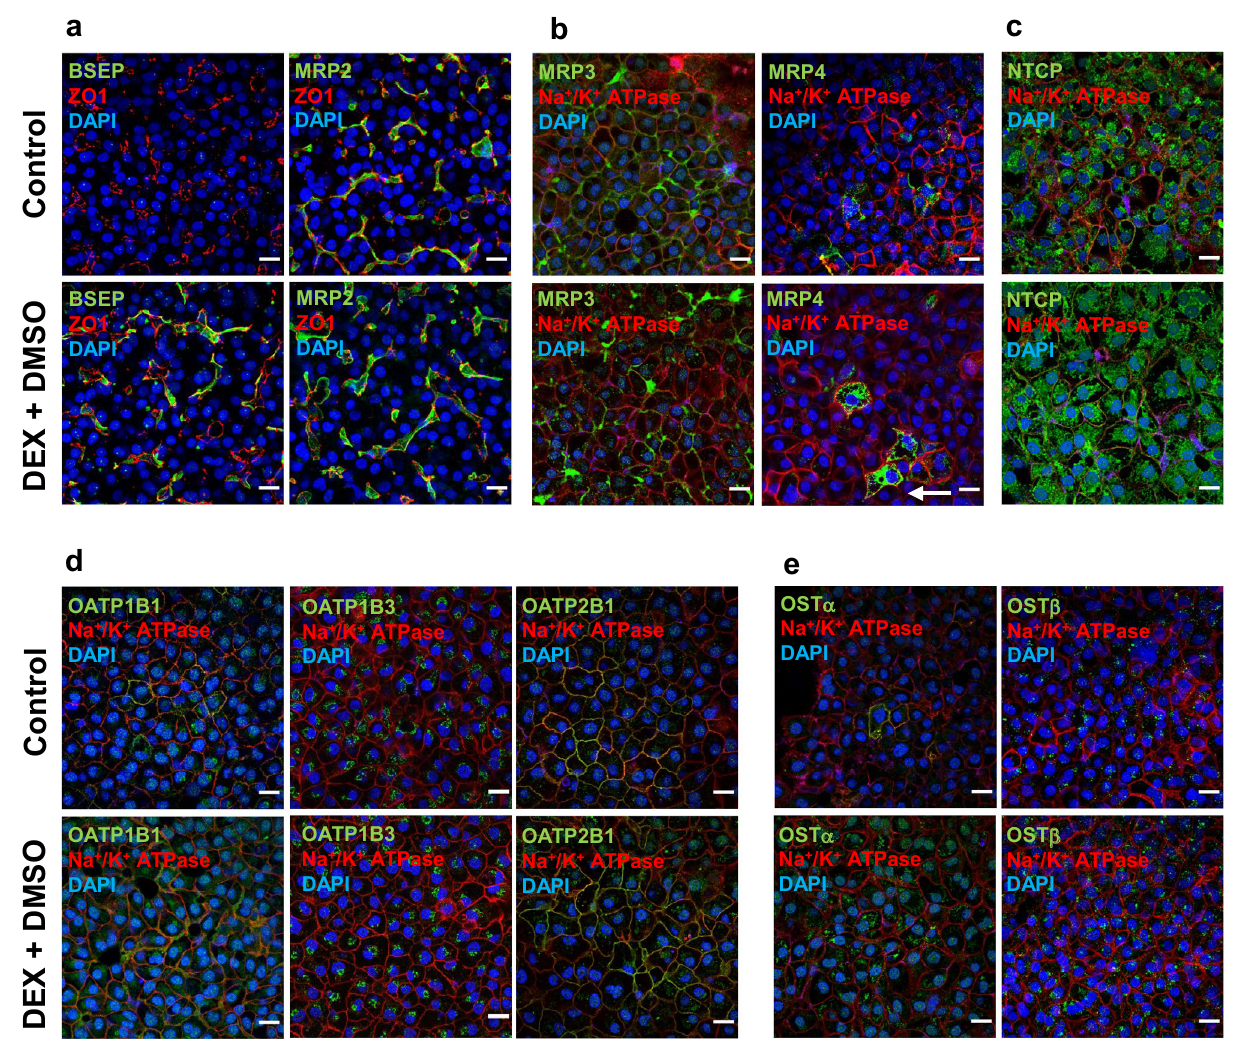
Figure 4. Cellular localization of bile acid transporters in control and differentiated HuH-7 cells with overlay. Immunofluorescence and confocal microscopy were performed to examine transporter localization in control and differentiated [culture medium contained 1 µM dexamethasone (DEX) + 0.5% DMSO] HuH-7 cells with overlay. Immunostaining of zonula occludens 1 (ZO1) and Na + /K + ATPase were used as markers for the canalicular and basolateral membranes, respectively. The nucleus was stained with 4 ′ ,6-diamidino-2- phenylindole (DAPI). Localization of the following bile acid transport proteins was determined in control and differentiated HuH-7 cells ( a ) bile salt export pump (BSEP) and multidrug resistance-associated protein (MRP) 2, ( b ) MRP3 and MRP4 (white arrow indicates membrane localized protein), ( c ) sodium taurocholate co-transporting polypeptide (NTCP), ( d ) organic anion transporting polypeptide (OATP) 1B1, OATP1B3, and OATP2B1, and ( e ) organic solute transporter (OST) α and OST β. At least three areas were randomly imaged for each sample. All projected images were analyzed using ImageJ software. Scale bar = 20